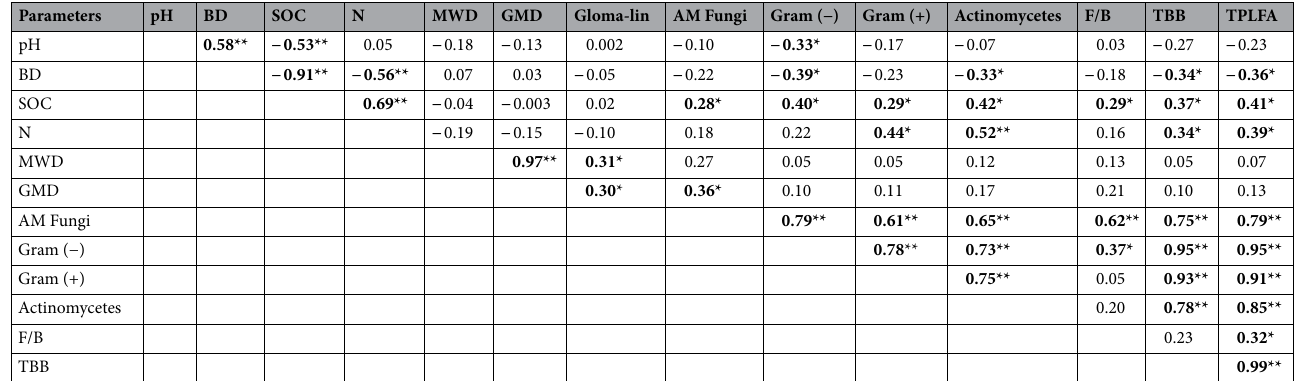
Table 4. Pearson’s correlation coefficient between soil physicochemical and biological properties under different productions systems. Values for BD, SOC and N were obtained from ref 31 . BD bulk density, SOC soil organic carbon, N nitrogen, MWD mean weight diameter, GMD geometric mean diameter, F/B fungi/ bacteria, TBB total bacterial biomass, TPLFA total phospholipid fatty acid. Bold numbers with ** represent the significant correlation at P ≤ 0.0001 and with * represent significant correlation at P ≤